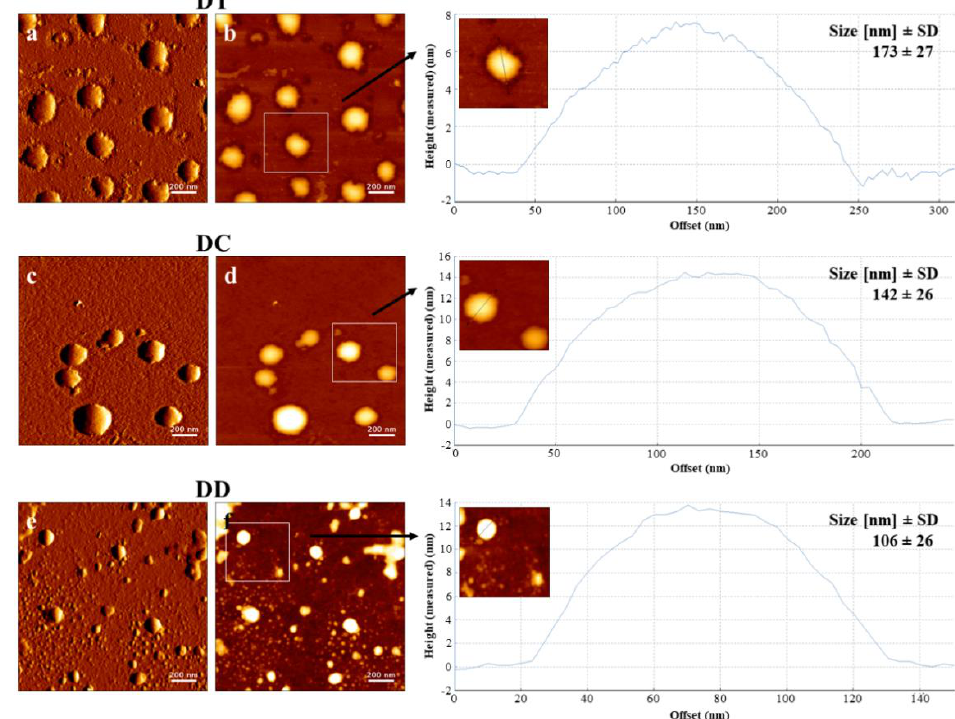
Figure 3. Atomic force microscopy (AFM) visualisation of DT, DC and DD after nebulisation with PARI VELOX ® , containing a curcumin concentration of 100 µM. Images ( a , c , e ) are amplitude signals and ( b , d , f ) are height signals. Liposomes in height images together with their cross-sectional profiles were used for a size evaluation along the shown lines and a morphological characterisation. The stated sizes are mean values ± standard deviation gathered by analysing representative height images using ImageJ software. Scale bars represent 200 nm.